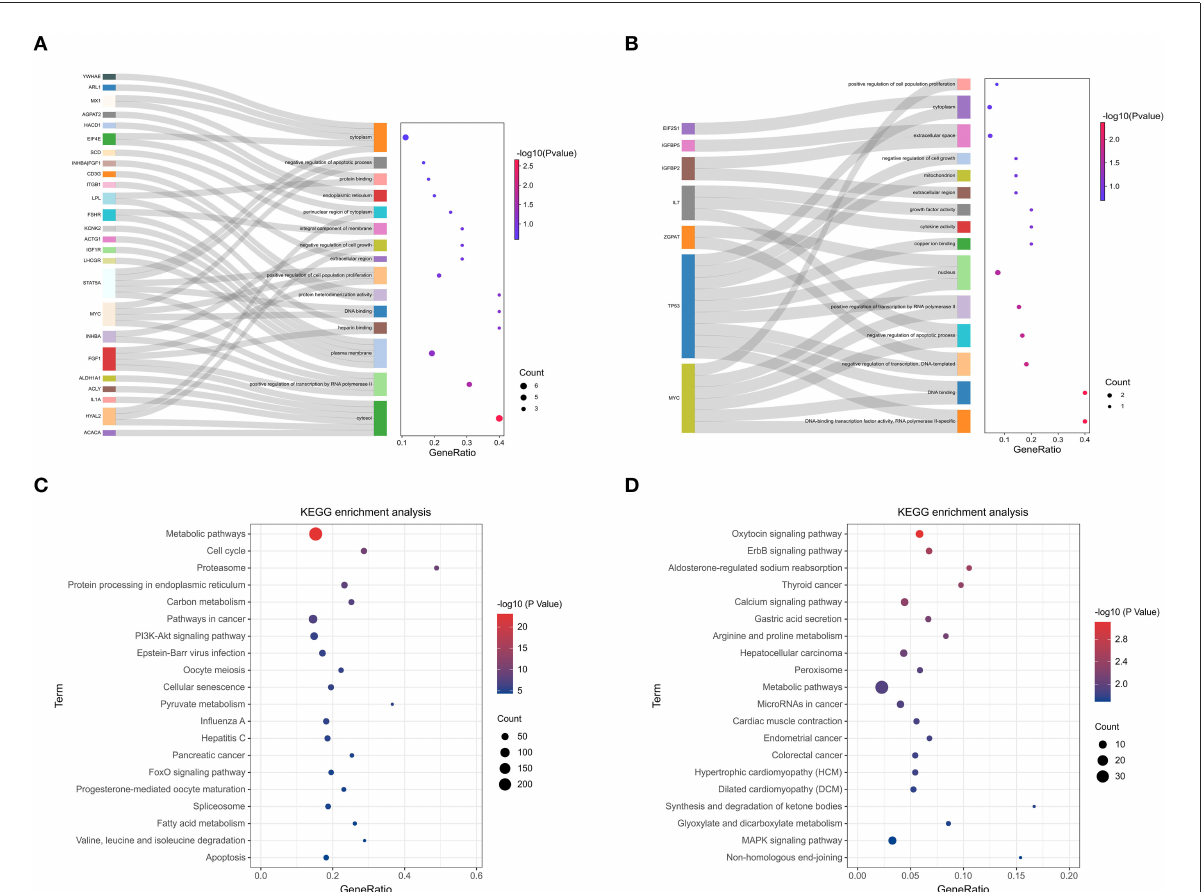
FIGURE9 KEGG pathway enrichment analysis of key module. (A) GO analysis of the black module and yellow module. (B) GO analysis of the light cyan module and salmon module. (C) KEGG enrichment analysis of black module and yellow module. (D) KEGG enrichment analysis of the lightcyan module and salmon module.